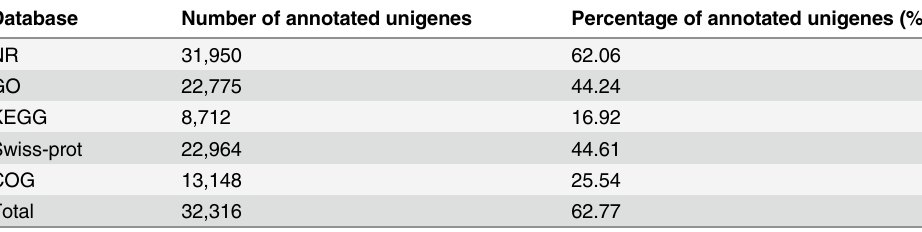
Table 3. BLAST analysis results of ‘ Hangbaishao ’ against fi ve public